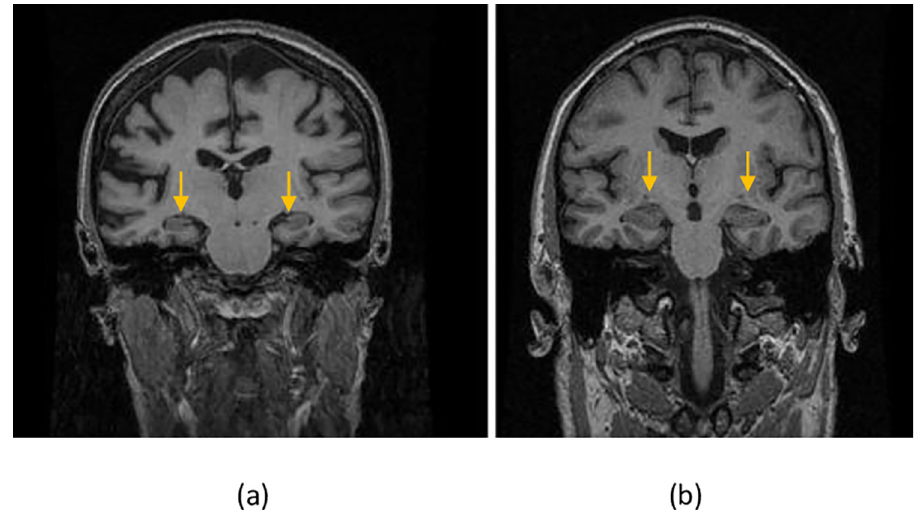
Fig 1. Coronal T1 weighted MRI images of (a) Alzheimer’s patient ID-201 and (b) normal patient ID-200 of the MIRIAD dataset. The FreeSurfer software divides the brain into left and right hemispheres and segments the medial temporal lobe into hippocampus, entorhinal, amygdala and para-hippocampal subregions.